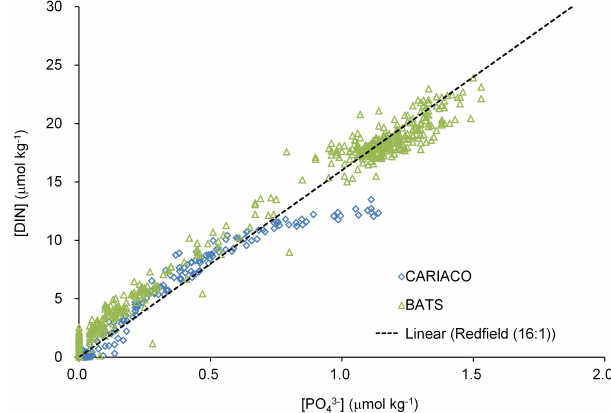
Fig. 8. Phosphate (SRP) versus DIN concentrations in waters with dissolved O 2 concentrations above ∼ 65µmolkg − 1 from the CARI- ACO Time Series and BATS during 2008 and 2009.